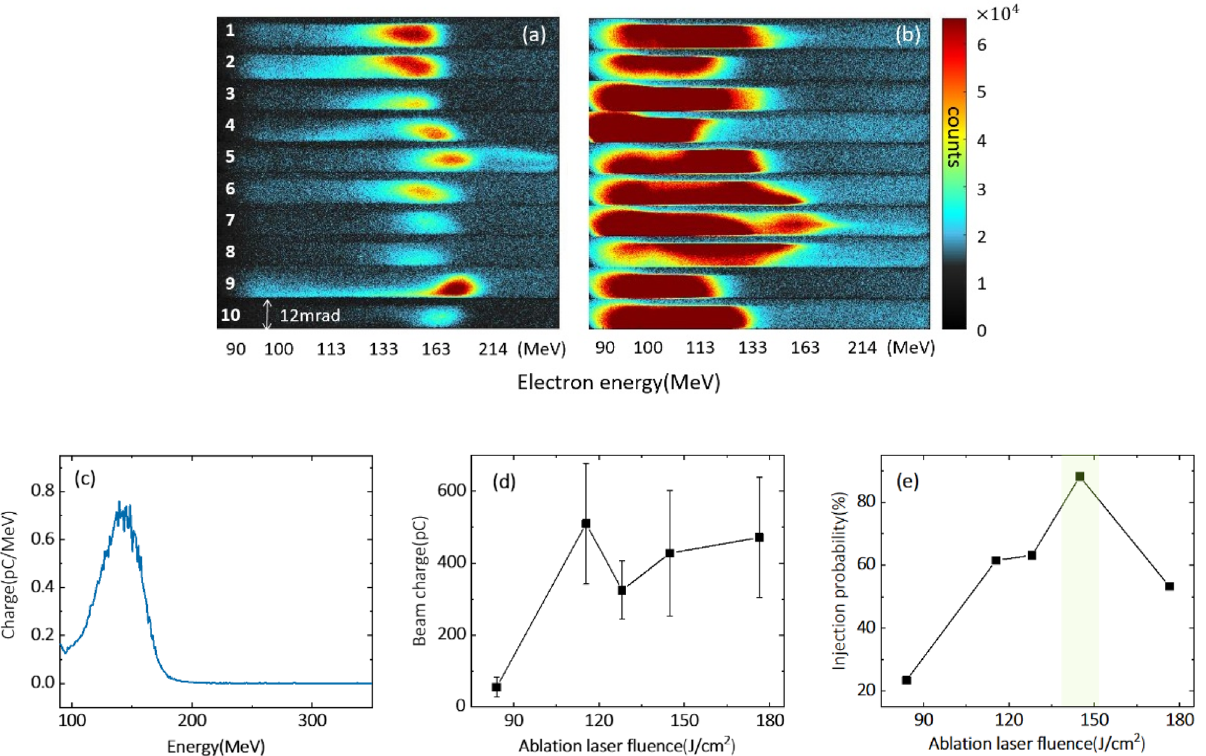
Figure 3. Electron bunch generation with respect to the fluence of the ablation laser. Electron energy spectra of ten laser shots, recorded on Lanex 2, are compared for the ablation energy densities of ( a ) 84 and ( b ) 145 J / cm 2 . ( c ) A typical energy spectrum of electron bunch with ablation laser energy of 84 J / cm 2 . Both beam charge ( d ) and injection probability ( e ) were measured while changing the fluence of the ablation